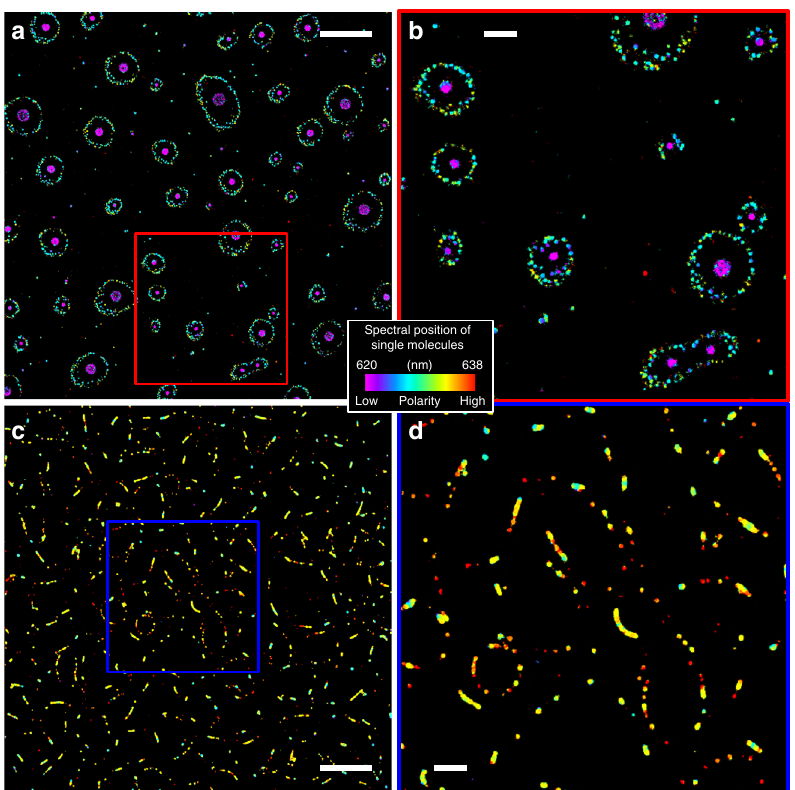
Fig. 5 SR-PAINT reveals the effect of mixture composition on adlayer structure and composition for the TCE-chloroform system. a , b True-color SR-PAINT images of adlayers from a 1:1 TCE-chloroform mixture, on the same spectral scale as Fig. 4 (620 – 638 nm). b is a zoom-in of the red box in a . c – d True-color SR-PAINT image of adlayers from a 1:6 TCE-chloroform mixture. d is a zoom-in of the blue box in c . Scale bars: 4 μ m ( a , c ) and 1 μ m ( b , d